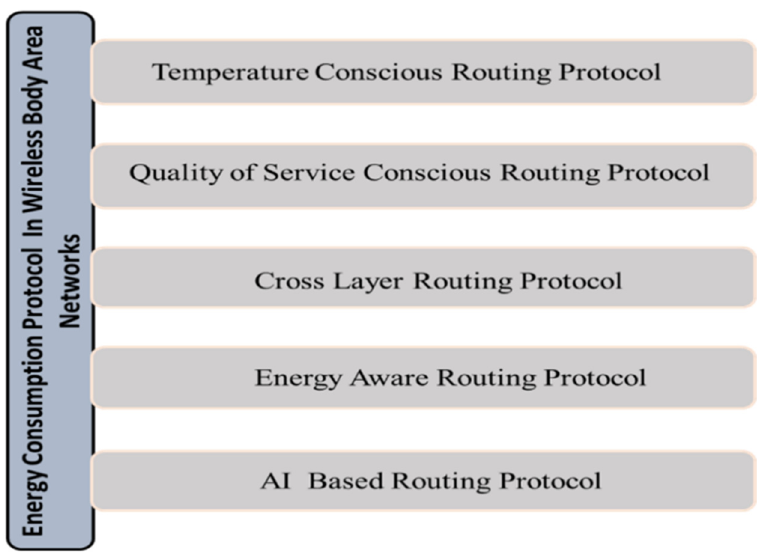
Figure 1. Routing protocol of WBAN.